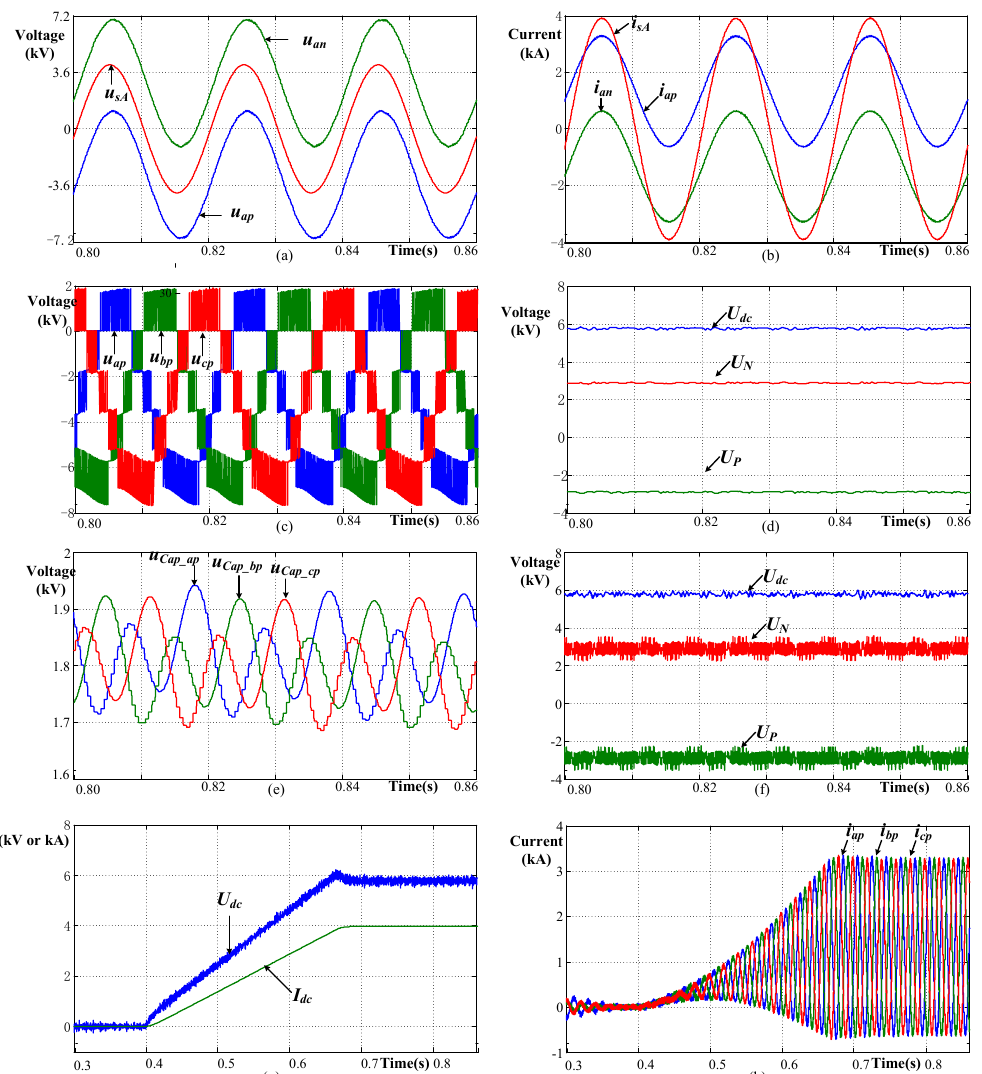
Figure 7. Simulation results of the optimized MMC-DDI. ( a ) arm voltage (fileted high-frequency ripple), ( b ) arm current, ( c ) arm voltage (unfiltered), ( d ) DC-side voltage (fileted high frequency ripple), ( e ) submodule capacitor voltage, ( f ) DC-side voltage (unfiltered), ( g ) DC-side output voltage and current during melting-ice startup process, ( h ) arm current during melting-ice startup process.